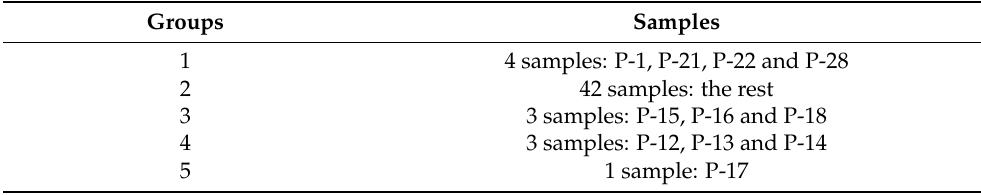
Table 7. Number of cases in each cluster.